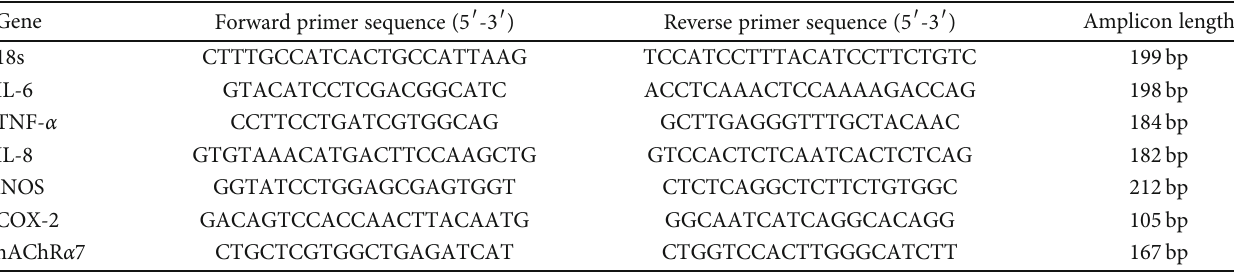
Table 1: Primer sequences used for real-time PCR reactions.